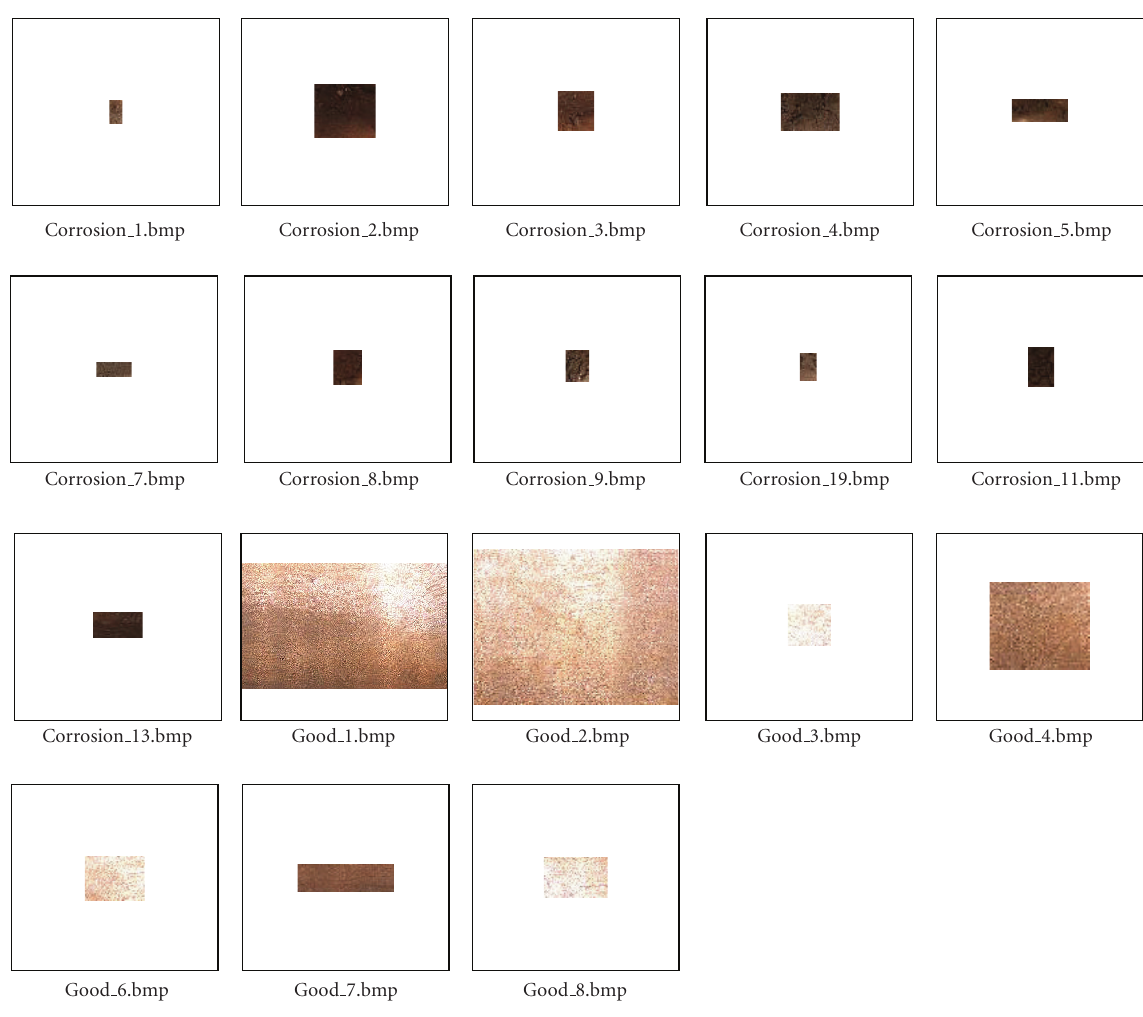
Figure 5: Rectangular regions of corrosion and good pipe.